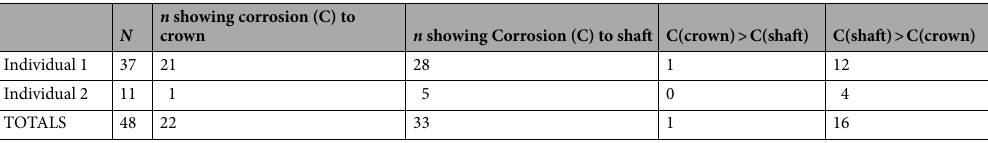
Table 2. Summary of corrosion damage to teeth of Green Anoles ( Anolis carolinensis ) ingested by Barn Owls ( Tyto alba ). Because jaws were generally whole, and there was frequently variation in degree of corrosion from anterior to posterior, the counts are based on the middle teeth (10–15) of the jaw. The number of uncorroded specimens cannot be derived by subtracting from the number of jaws ( N ), because some specimens could not be fully evaluated because of adhering matter (dirt,